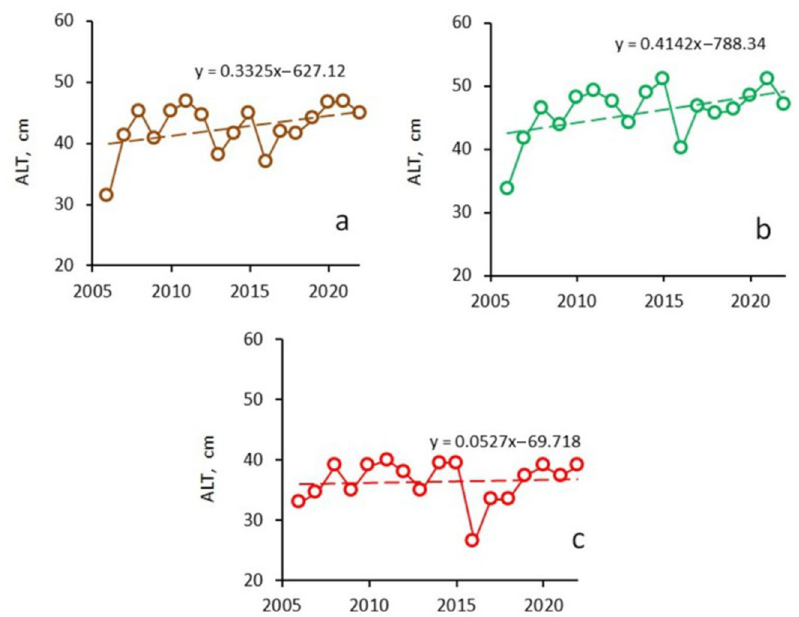
Figure 9. Active layer thickness in the wet ‐ tundra sites, 2006–2022. ( а )—flat moss hillocks in sub ‐ horizontal areas of the foothill plain; ( b )—swales in horizontal areas of the foothill plain; ( c )—moss hillocks in the gentle lower hillslopes.